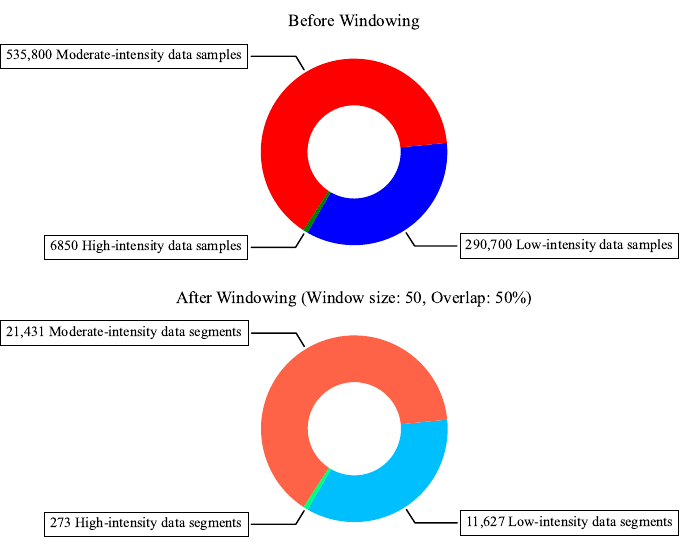
Figure 4. Illustration of sampling method for the AVM data bundle.